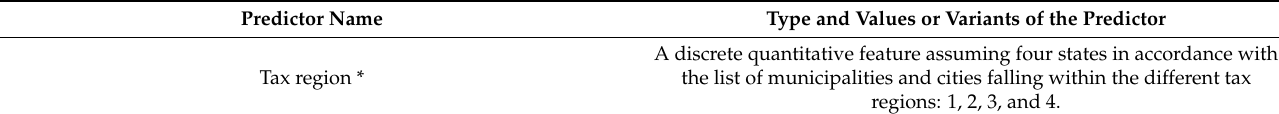
Table 1. A list of predictors used for constructing the MRA and ANN